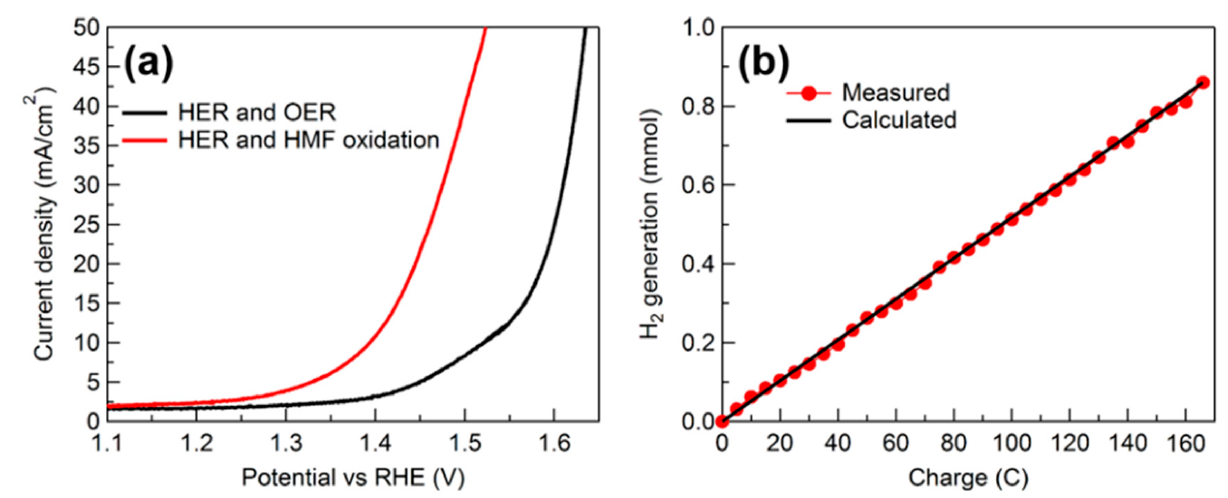
Figure 25. ( a ) LSV of two-electrode cell for concurrent 5-HMF oxidation and hydrogen evolution. ( b ) Amount of hydrogen theoretically calculated and measured at the cathode. Reprinted with permission from Ref [118]. Copyright 2016, ACS Energy Letters.